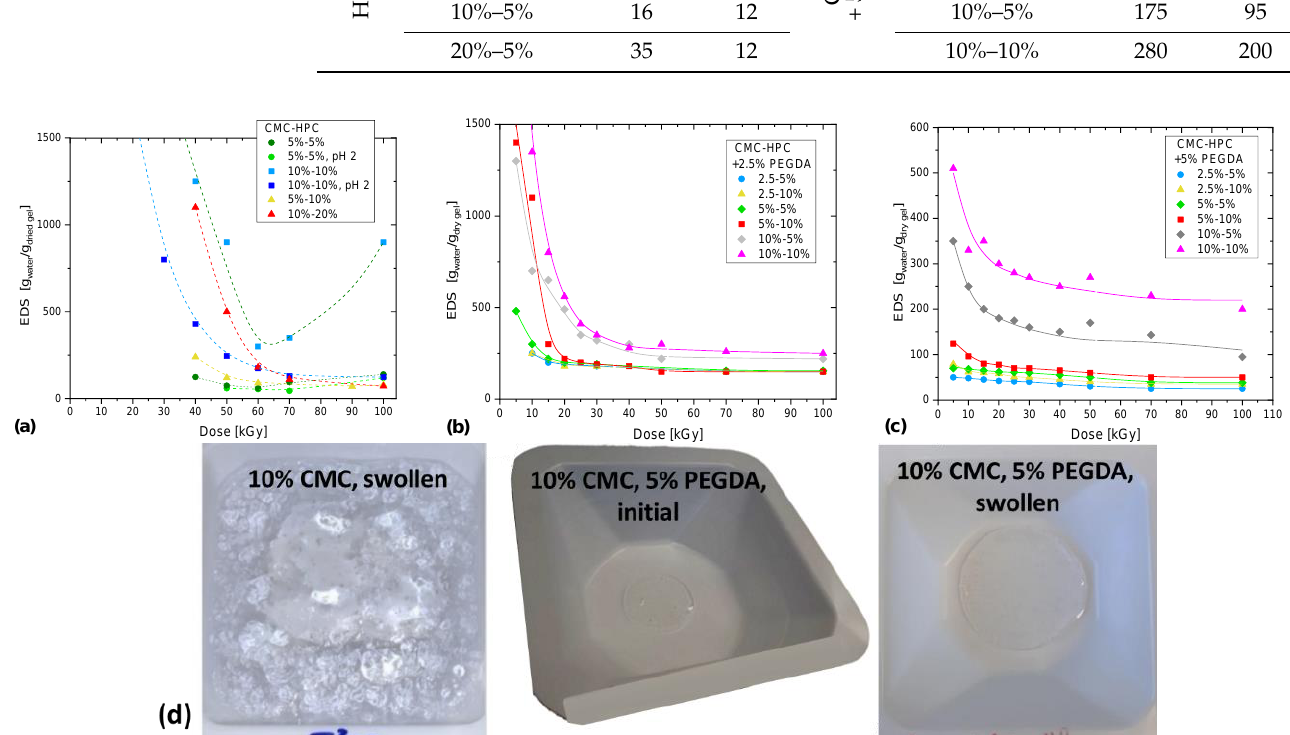
Figure 6. EDS in the water of hydrogels manufactured by the irradiation of CMC – HPC aqueous solutions ( a ) without PEGDA and with the crosslinker of ( b ) 2.5% and ( c ) 5% concentration, and ( d ) photographs of CMC hydrogels formed with 50 kGy: swollen without PEGDA and initial and swollen with the crosslinker (the same tray in all